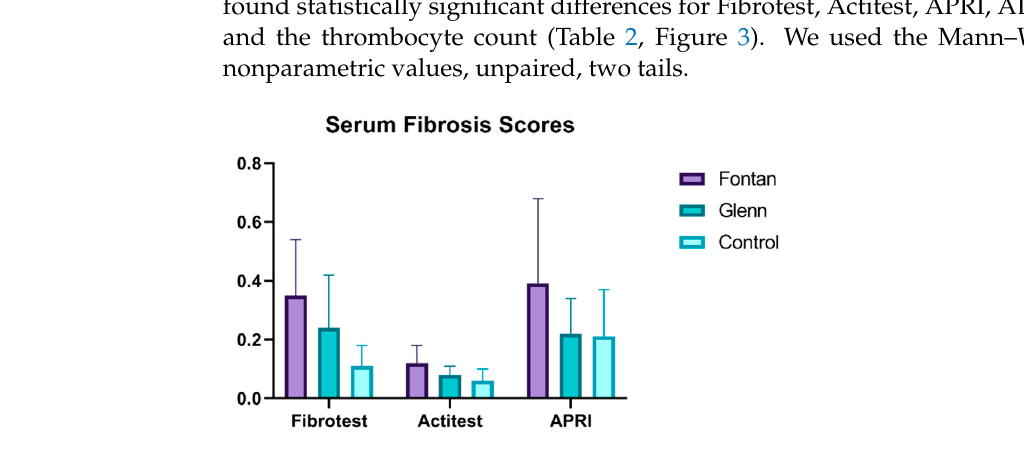
Figure 3. Mean Serum Fibrosis Scores.